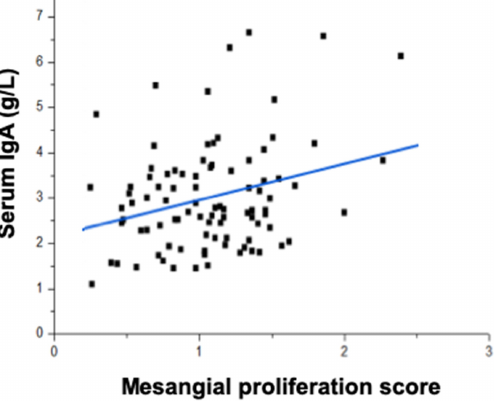
Figure 2. Glomerular mesangial proliferation correlates with serum total IgA level. Serum total IgA levels correlate with the mesangial proliferation score in patients with IgAVN. The line shows a linear fit ( p = 0.0056).